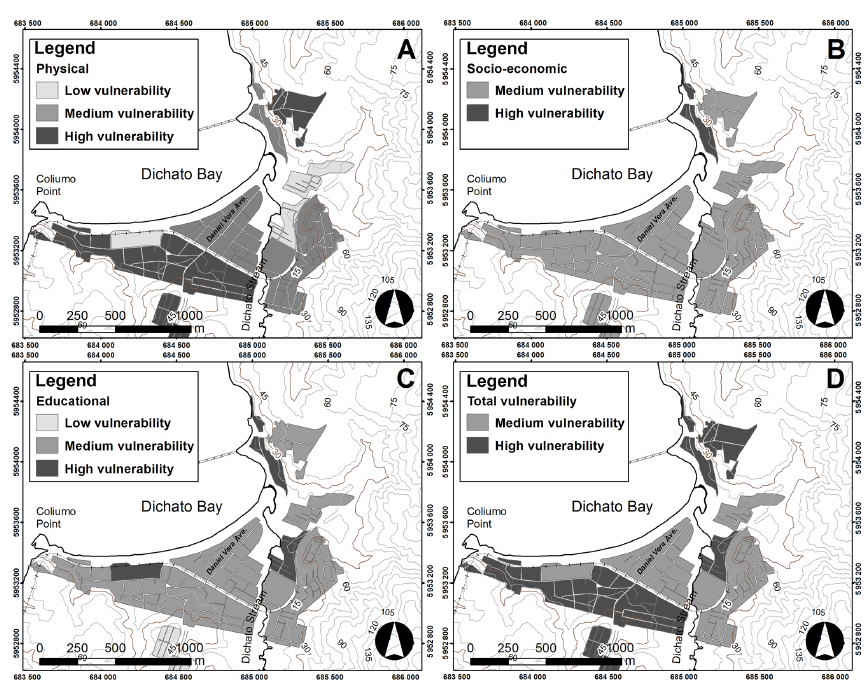
Figure 6. Post-event tsunami vulnerability of the town of